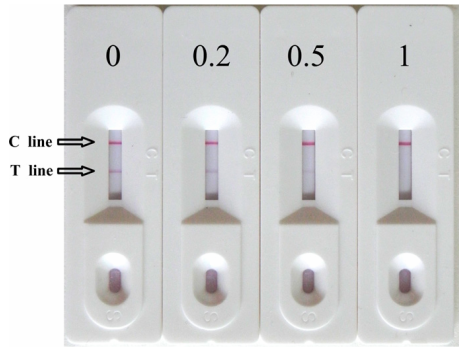
Figure 3. Typical photo image of detection MC-LR by strip sensor in